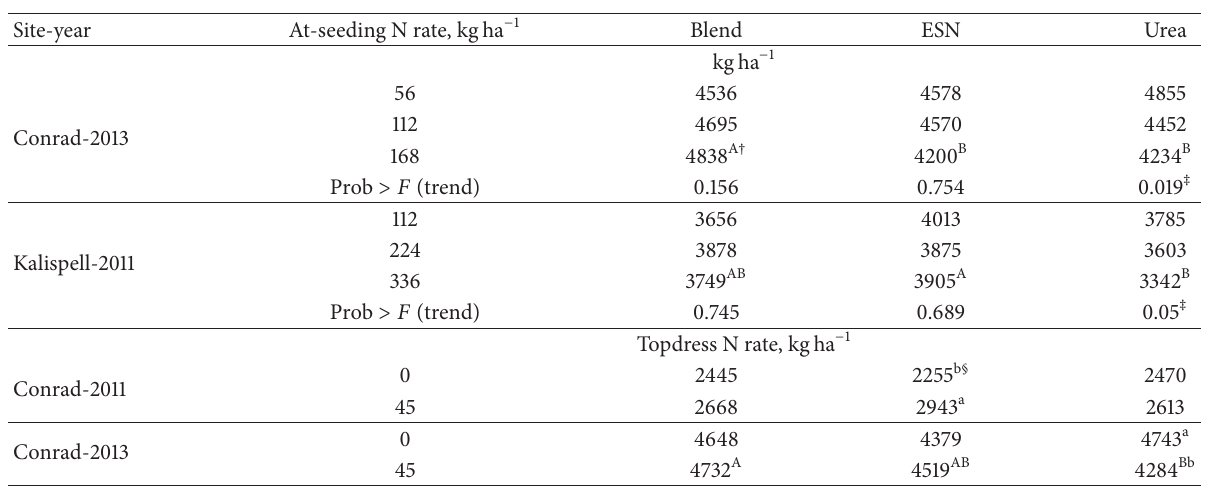
Table 3: (a) Simple effects of two-way interactions of source by at-seeding and topdress N rates for grain yield in selected site-years where interaction effect was significant at least at 𝑝 < 0.1 . (b) Simple effects of three-way interactions of source and at-seeding and topdress N rates on grain yield in selected site-years where interaction effect was significant at least at 𝑝 < 0.15